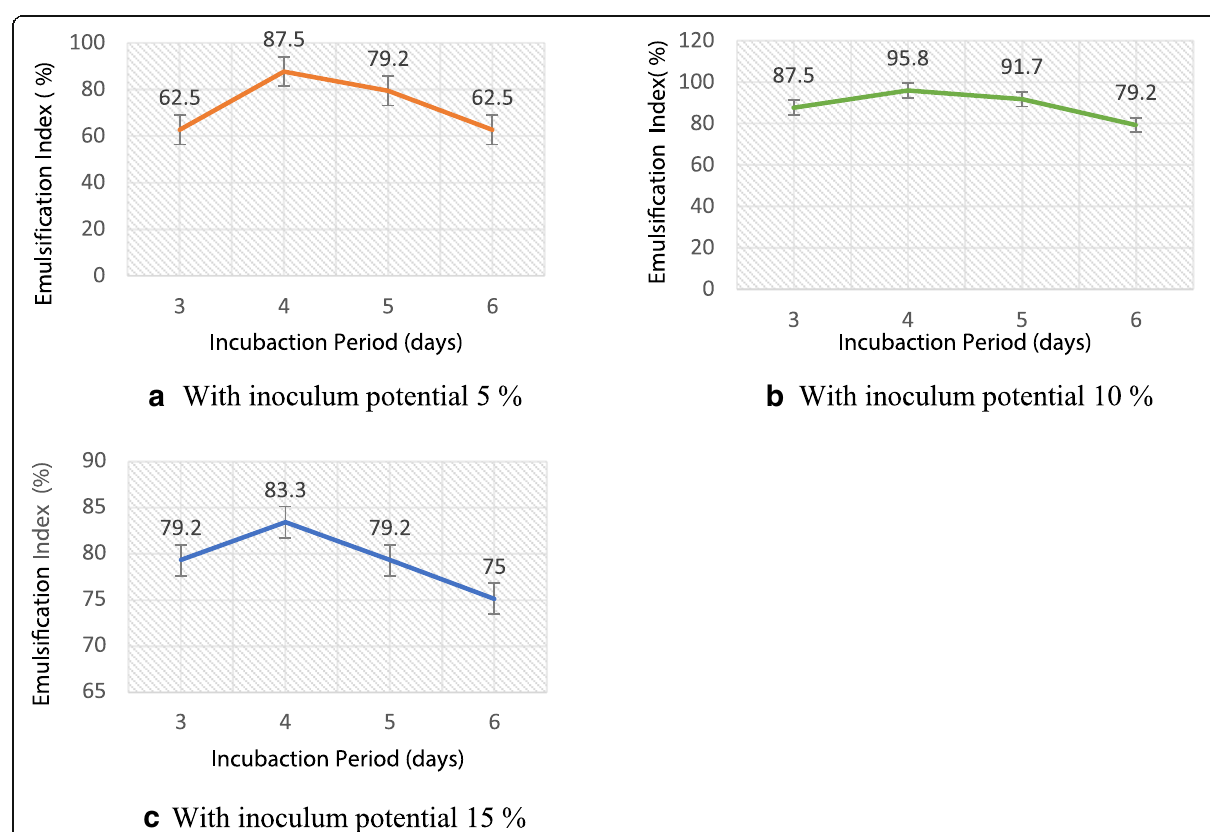
Fig. 7 a – c Effect of interaction between the inoculum potential and the incubation period on biosurfactants production by C. freundii MG812314.1.